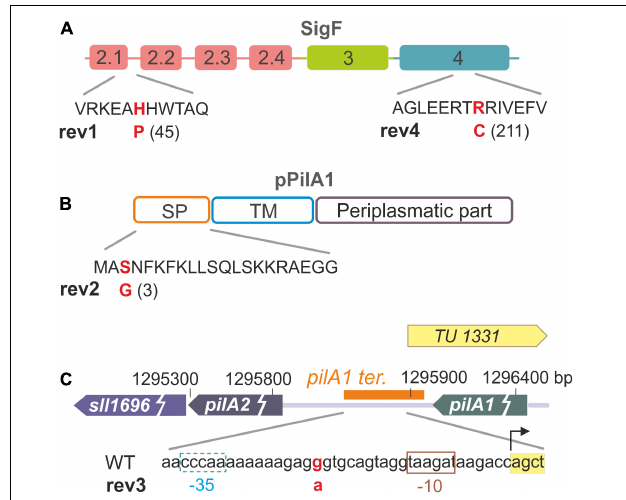
FIGURE 1 | Overview of mutations that restore photoautotrophic growth of the (cid:49) pilD strain. (A) Sigma factor SigF contains three main domains ( σ 2, σ 3, σ 4); the suppressor mutation in rev1 is located in the σ 2.1 region, which interacts with the TATA box of recognized genes. The SigF mutation found in the rev4 strain is located in domain σ 4, which typically interacts with the -35 segment of the promoter (see a structural model bellow). Note that the rev4 strain contains another suppressor E95K mutation in the RNAP γ subunit. (B) The mutation identified in the rev2 strain causes the S3G amino-acid substitution in the signal peptide of the PilA1 protein. (C) The rev3 strain contains a point nucleotide substitution in the intergenic region between genes coding for the pilin proteins PilA1 and PilA2. Transcription unit TU1331 including its promoter (–10 and –35 elements; Kopf et al., 2014) is depicted together with the predicted pilA1 terminator (orange box; Hess, W. personal communication). According to Kopf et al. (2014), pilA2 and sll1696 genes do not have their own promoter, instead they seem to form one transcriptional unit with pilA1